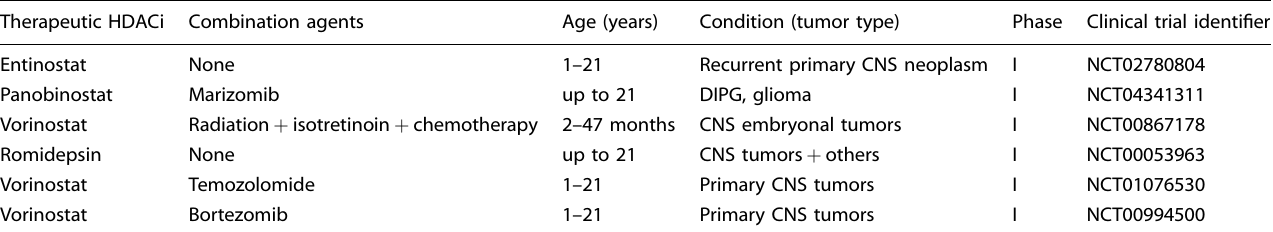
Table 1. Selected clinical trials on HDACis in pediatric